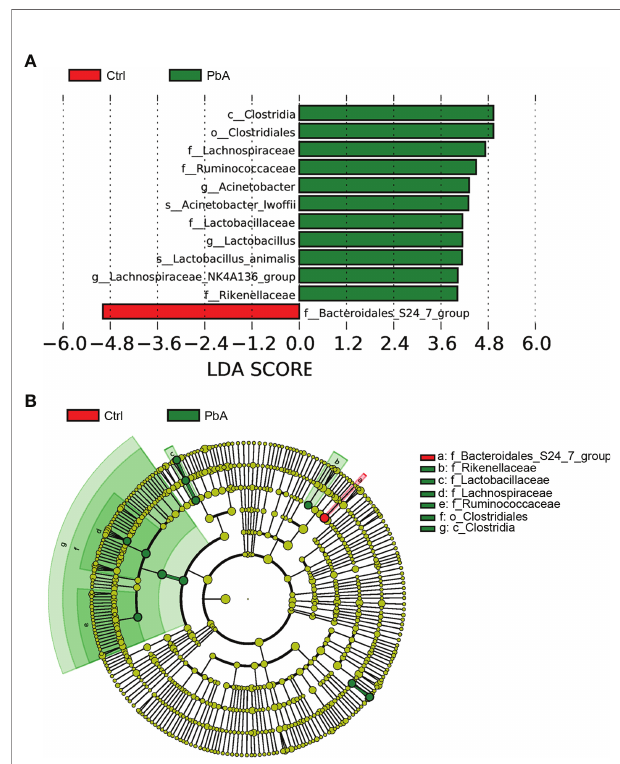
FIGURE 5 | The most differential abundant taxa in different groups. (A) LEfSe identi fi ed the bacterial taxa that signi fi cantly differentiated the Ctrl and PbA mice. Histogram of the linear discriminant analysis (LDA) scores distribution between the Ctrl and PbA groups. Only taxa with statistical differences between groups are displayed in the fi gure, which was determined by meeting an LDA signi fi cance threshold > 4. (B) Cladogram of the most differentially abundant bacterial taxa in the two groups. The red and green colors represent the bacterial communities of the Ctrl and PbA groups,